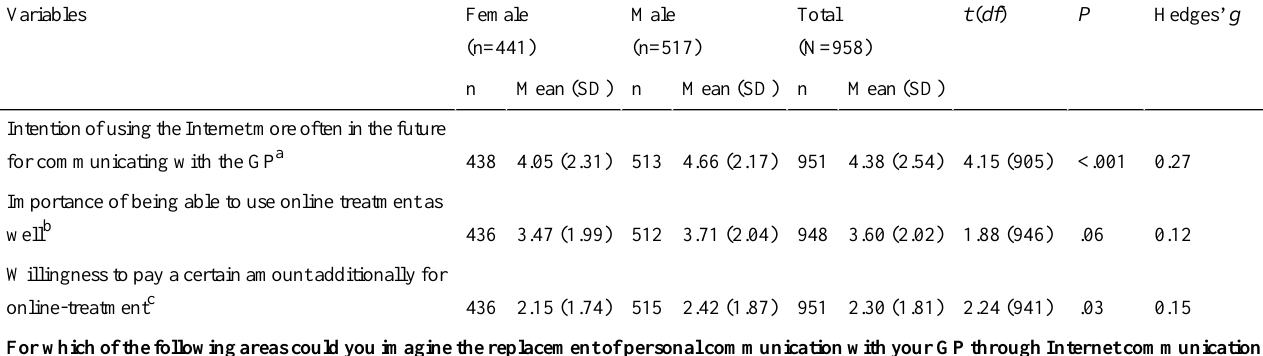
Table 7. Gender differences for future intention to replace personal communication and treatment by the